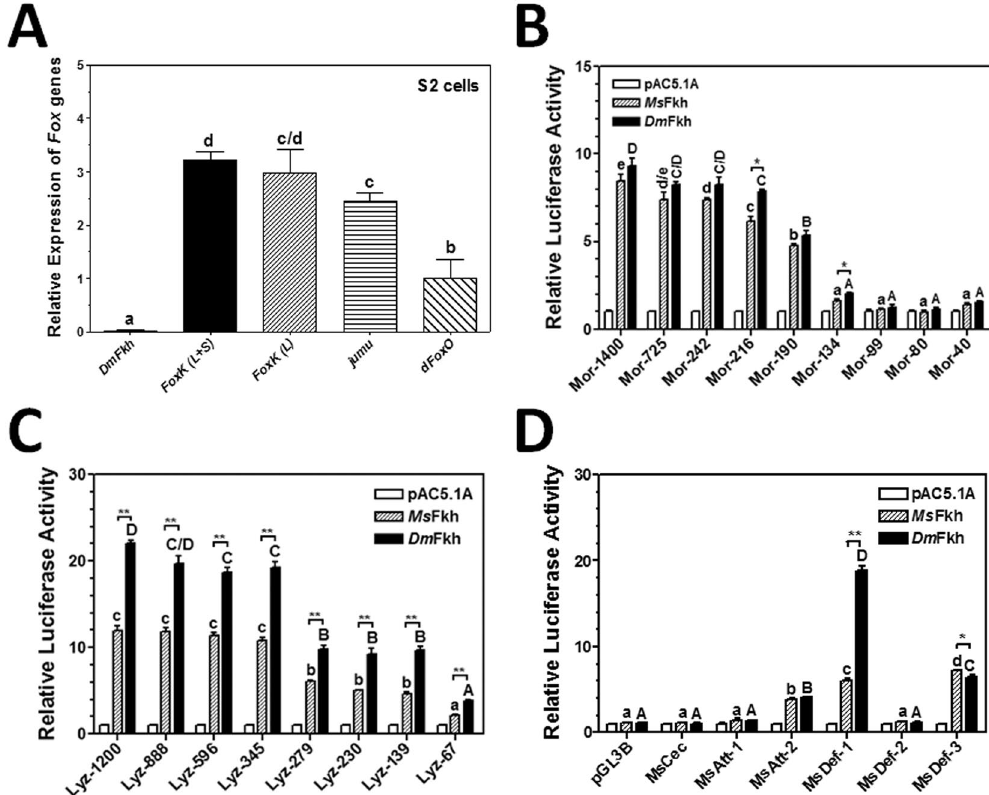
Figure 4. Activation of AMP gene promoters by M. sexta and D. melanogaster Fkh factors. ( A ) Real-time PCR analysis of transcripts of Fkh ( DmFkh ), FoxK long and short isoforms ( FoxK (L + S)), FoxK long isoform ( FoxK (L)), jumu and FoxO ( dFoxO ) in S2 cells. Drosophila ribosomal protein 49 ( rp49 ) gene was used as an internal standard. ( B – D ) Activation of AMP promoters by overexpression of MsFkh and DmFkh. The relative luciferase activities of truncated moricin promoters ( B ), truncated lysozyme promoters ( C ), and different M. sexta AMP gene promoters ( D ) activated by recombinant MsFkh or DmFkh in S2 cells were determined by Dual-Luciferase ® Reporter Assay System as described in the Materials and Methods. Bars represent the mean of three independent measurements ± SEM. For transcription levels of Fox genes in S2 cells ( A ), or relative luciferase activity ( B – D ) among different promoters activated by one transcription factor (comparing striped bars or solid bars), identical letters are not significant difference (p > 0.05) while different letters indicate significant difference (p < 0.05). For the activity of the same promoter stimulated by different transcription factors (between MsFkh and DmFkh), the significance of difference was also determined by an unpaired t-test ( * p < 0.05; ** p < 0.01). MsCec, MsAtt-1, MsAtt-2, MsDef-1, MsDef-2 and MsDef-3 are M. sexta